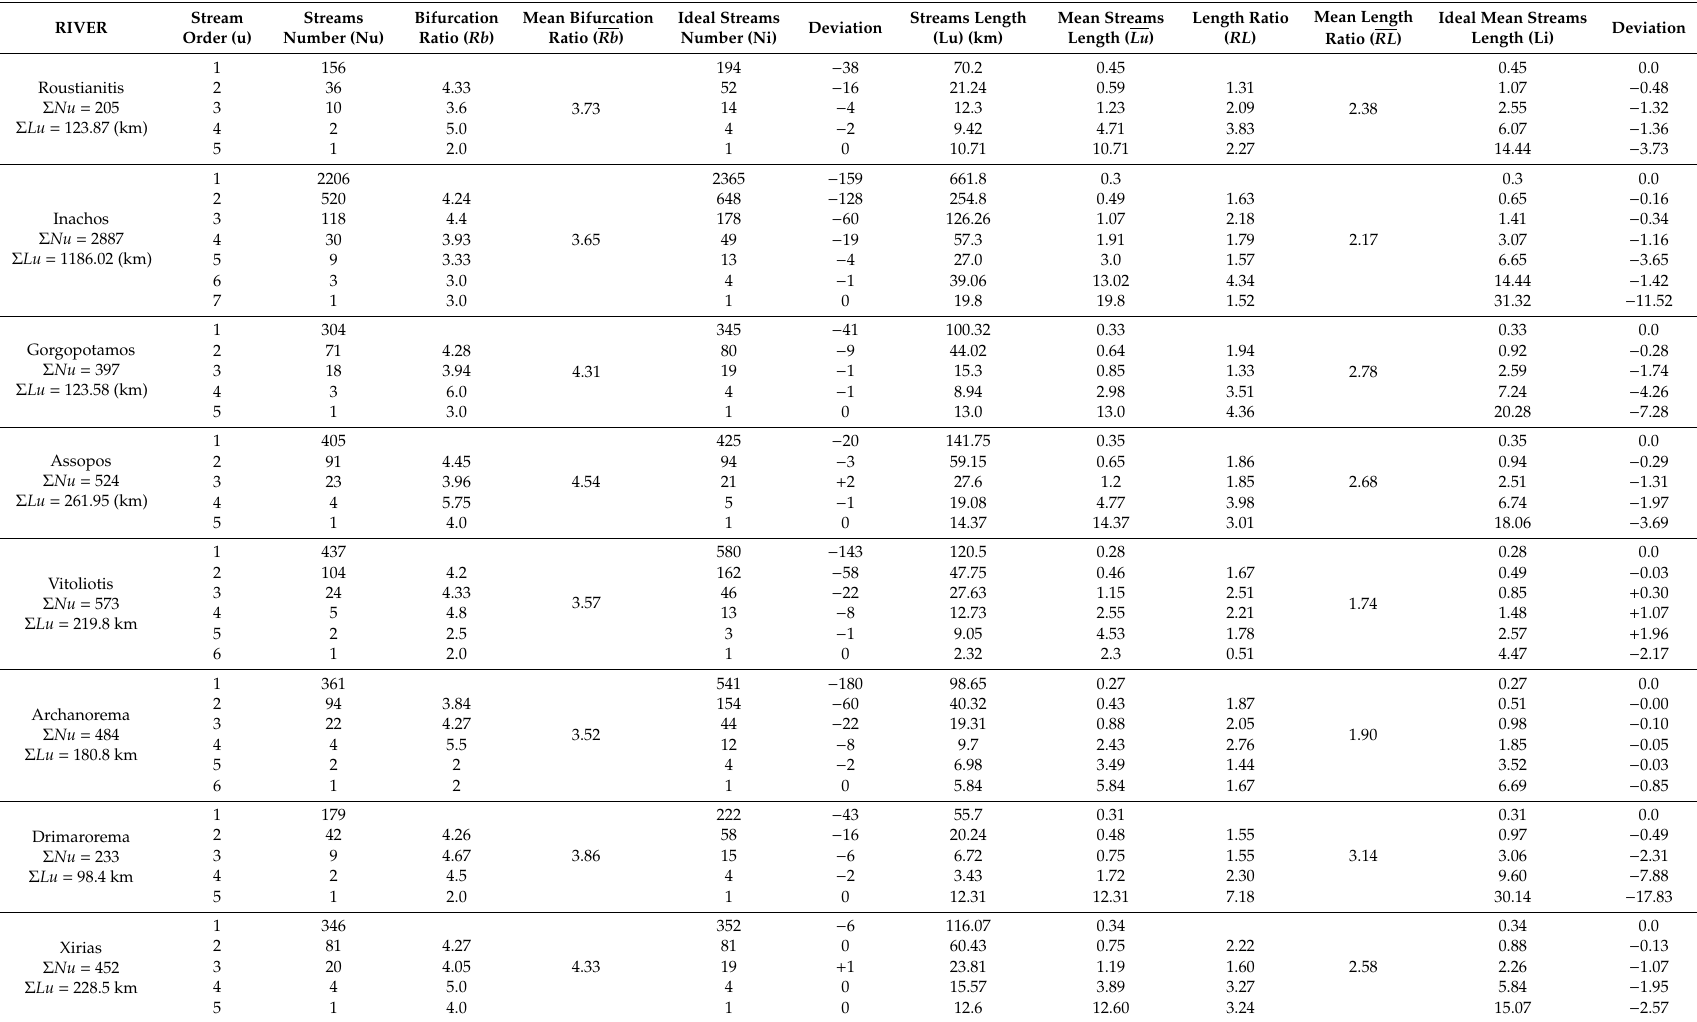
Table 2. Horton’s first and second law values for the four